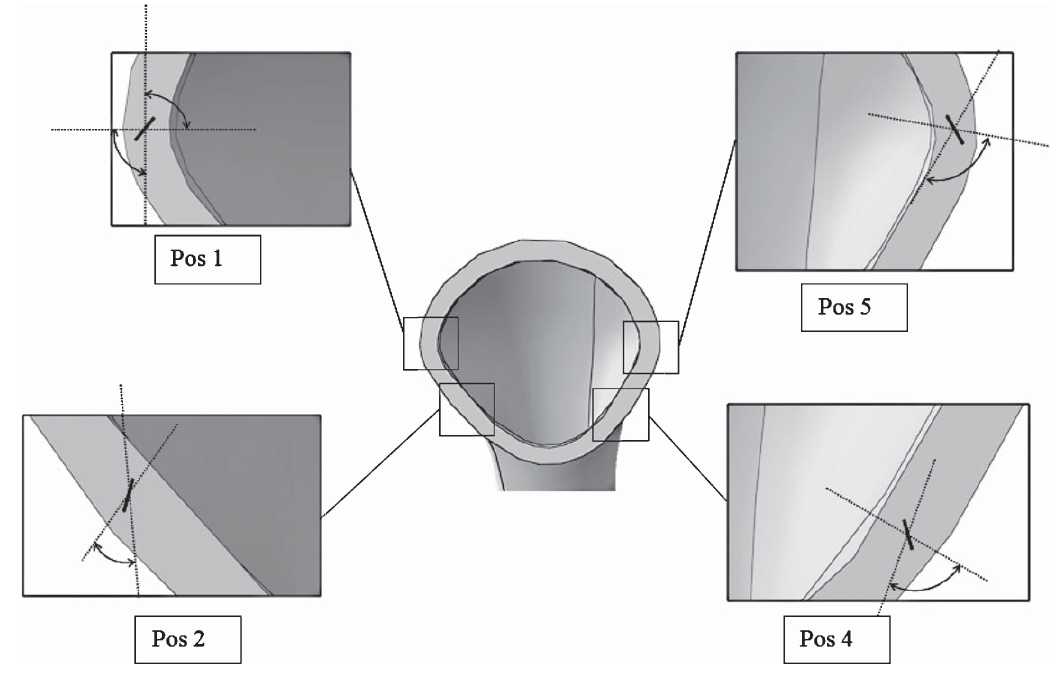
Fig. 18. Figure showing the most critical crack orientation within opening range (K I > 0) for each